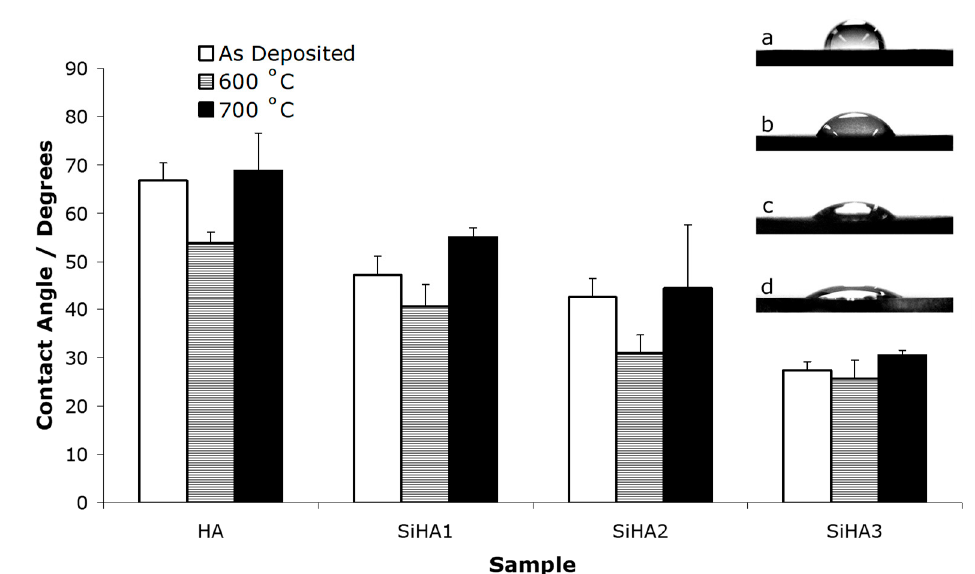
Figure 9. Measured contact angles of water droplets on HA and SiHA thin sputtered films. Mean ± standard error of the mean where n ≥ 6. Also shown are digitally enhanced representative grayscale photographs of water droplets on ( A ) HA ( B ) SiHA1 ( C ) SiHA2 and ( D ) SiHA3 thin sputtered films, showing the effect of silicon doping on the contact angle of water. Photographs taken from as deposited sample set.